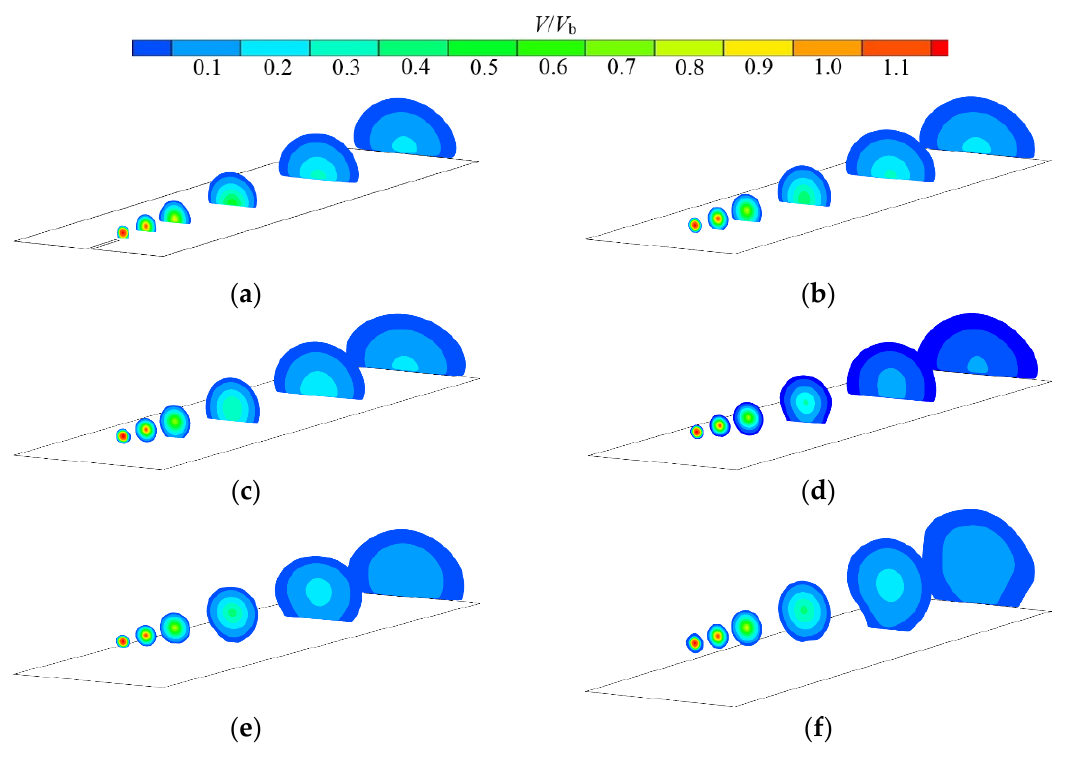
Figure 9. V / V b distribution contours of longitudinal section ( oyz plane) of jet under different H / D conditions: ( a ) H / D = 0.5; ( b ) H / D = 1; ( c ) H / D = 1.5; ( d ) H / D = 2; ( e ) H / D = 3; and ( f ) H / D = 4.